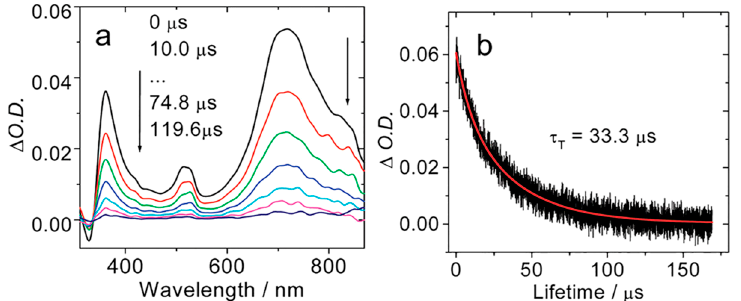
Figure 15. ( a ) Nanosecond transient absorption spectra of BDP-C 60 -1 ( λ ex = 532 nm). ( b ) Decay traces of the transient absorption of BDP-C 60 -1 at 720 nm (black line: experimental spectrum, red line: fitting result). In deaerated toluene, 25 °C. Reproduced with permission from reference [78], copyright 2012, American Chemical Society.